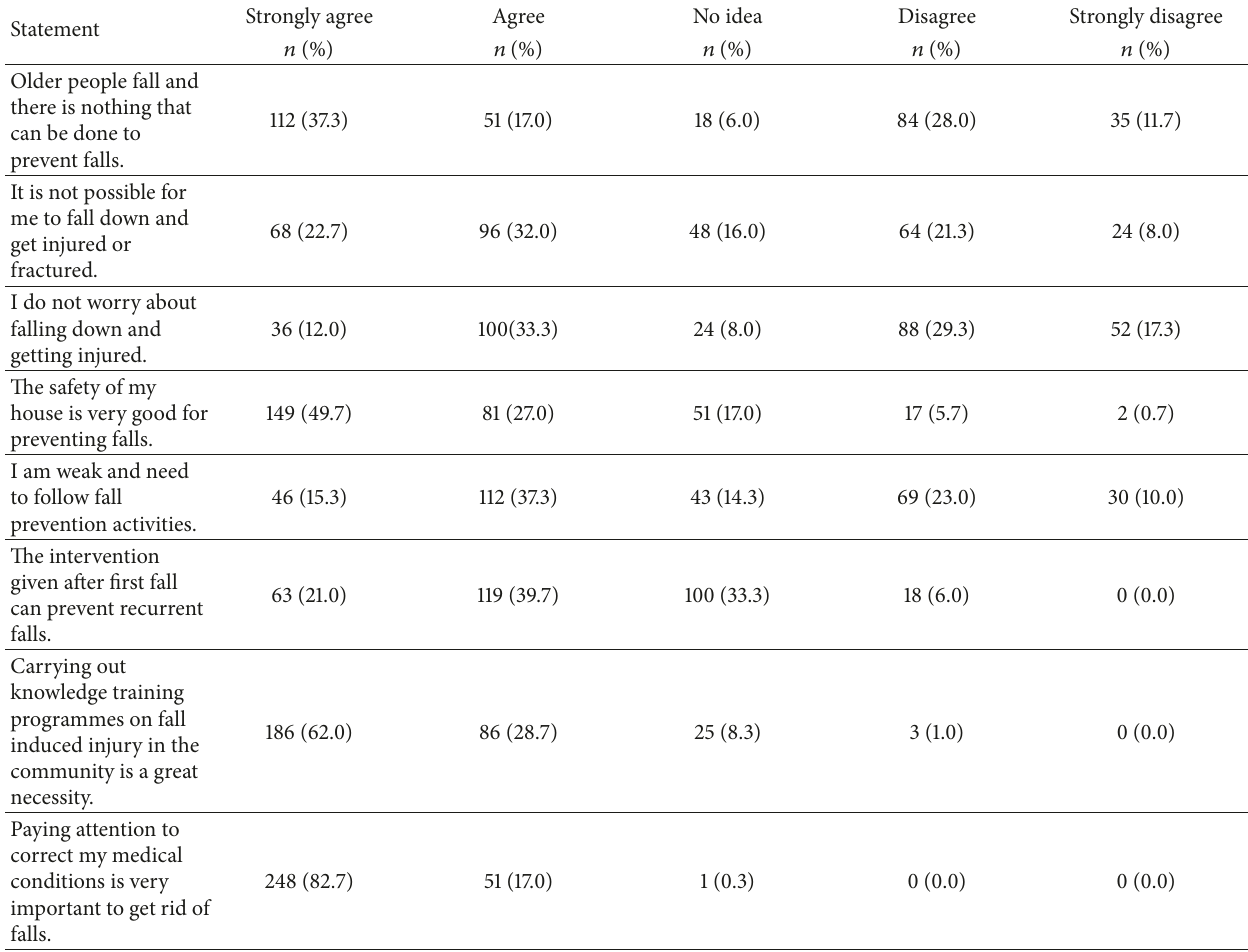
Table 5: Statements that describe the perception towards falls ( 𝑛 = 300 ).